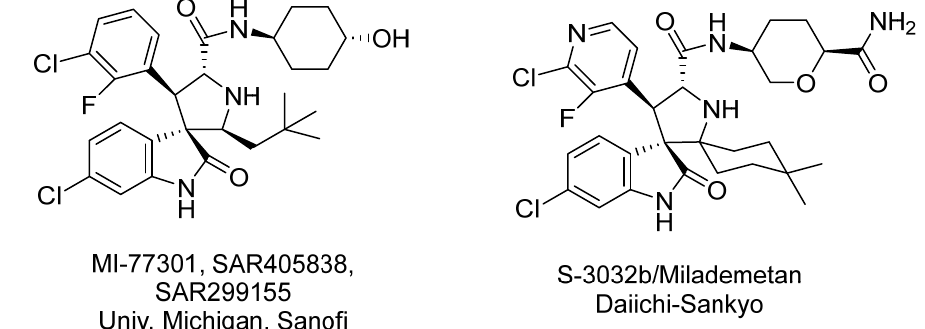
Figure 8. MDM2-p53 inhibitors entered in human clinical trials. Azomethine cycloaddition derived from amino acid derivative 61 in MeOH under microwave irradiation at 100 °C with isatin afforded the spirooxindole derivative 62 as a racemic mixture followed by a reductive amination reaction with cyclopropane carboxal- dehyde and then N -arylation of lactam in Buchwald coupling conditions, with p -bromo- benzoate giving the final target spirooxindole 63 (Scheme 15). Promising efficacy was no- ticed towards MDM2-p53 and SJSA-1 (p53 wild-type osteosarcoma) (IC 50 = 161 nM) [34].